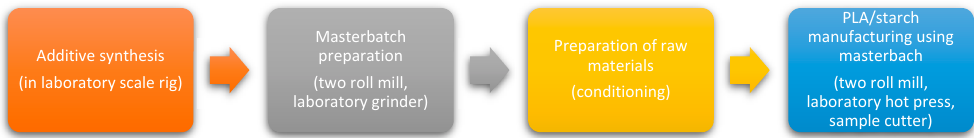
Figure 1. The main steps of the sample preparation.